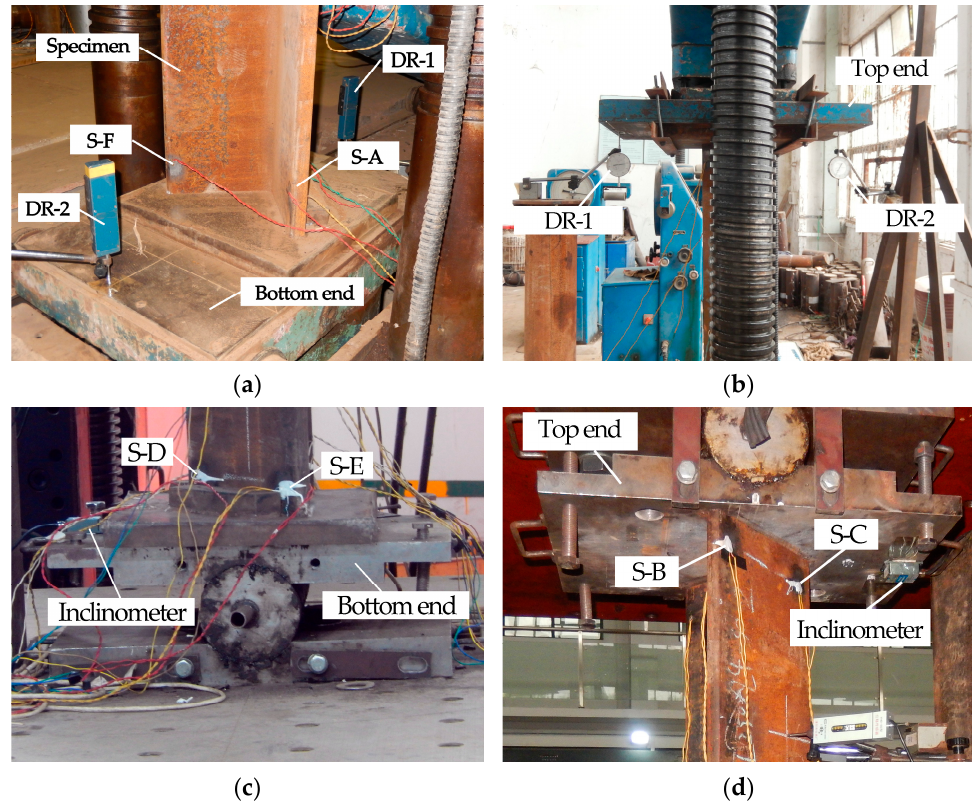
Figure 4. The actual set-up: ( a ) The bottom of 500 t; ( b ) The top of 500 t; ( c ) The bottom of 3000 t; ( d ) The top of 3000 t.